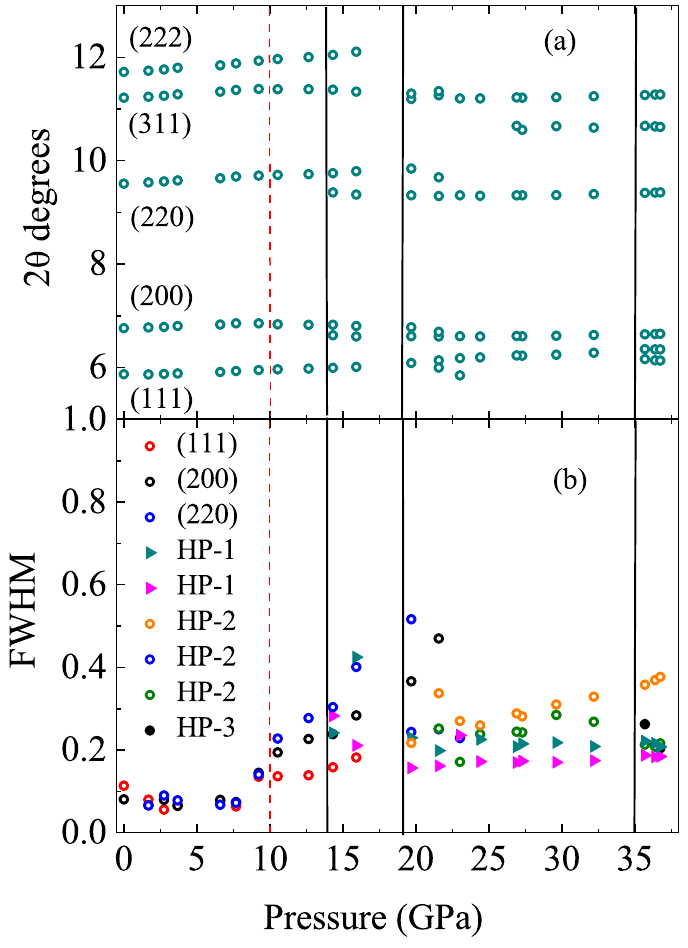
Figure 7. Behaviour of the ( a ) Bragg peaks and ( b ) FWHM with pressure. The vertical red dashed line indicates the hydrostatic limit of the PTM used. Solid black lines mark the transition